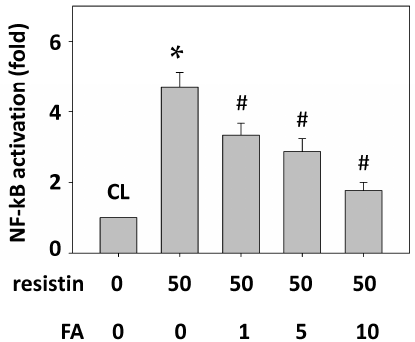
Figure 7. FA inhibits the resistin effect on HCT-116 cell adhesion to HUVECs by down-regulating NF- κ B activity. HCT-116 cells were pretreated with FA at 0, 1, 5 and 10 μ g/mL and then were maintained as control or stimulated with resistin. The activation of NF- κ B was determined. Data represent the mean ± SEM from three independent experiments. * p < 0.05 vs. control cells; # p < 0.05 vs. cells treated with resistin only.